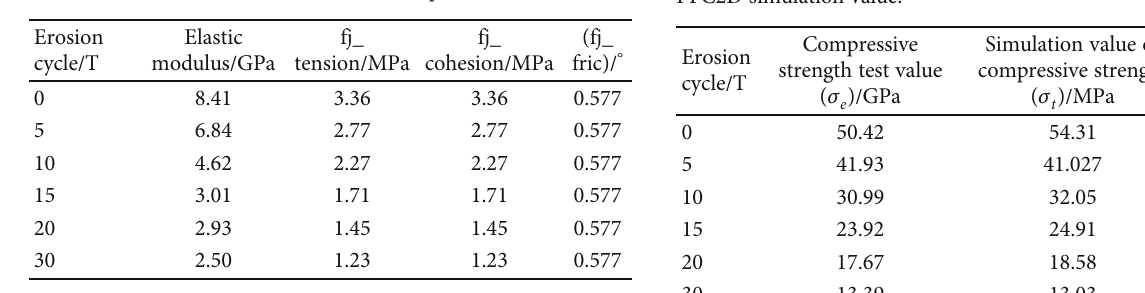
Table 4: Comparison between uniaxial compression test value and PFC2D simulation